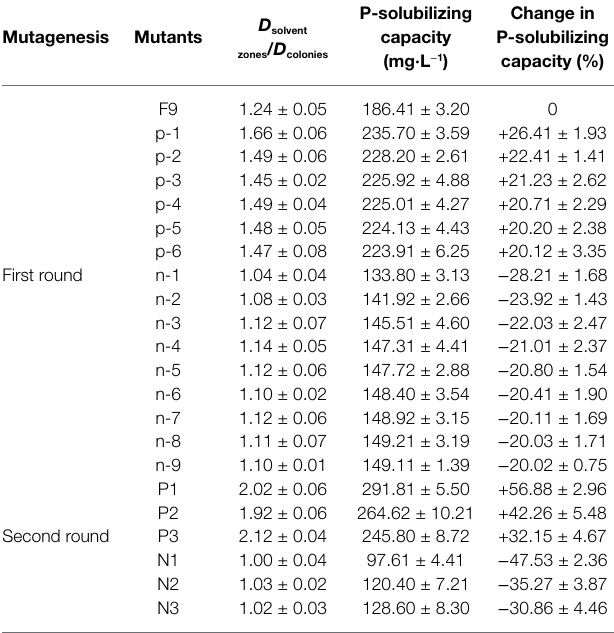
phosphate-solubilizing ability ( Table 3 ). The phosphate- most significantly (235.70 mg·L − 1 ), up by 26.40% compared with